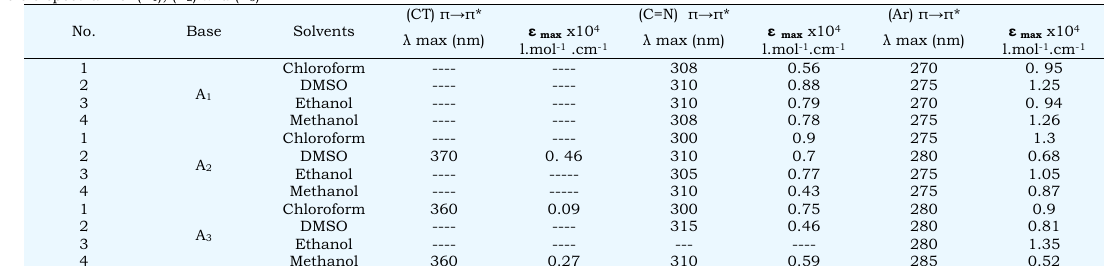
Table 1 The UV-visible spectrum of (A 1 ), (A 2 ) and (A 3 ) No.